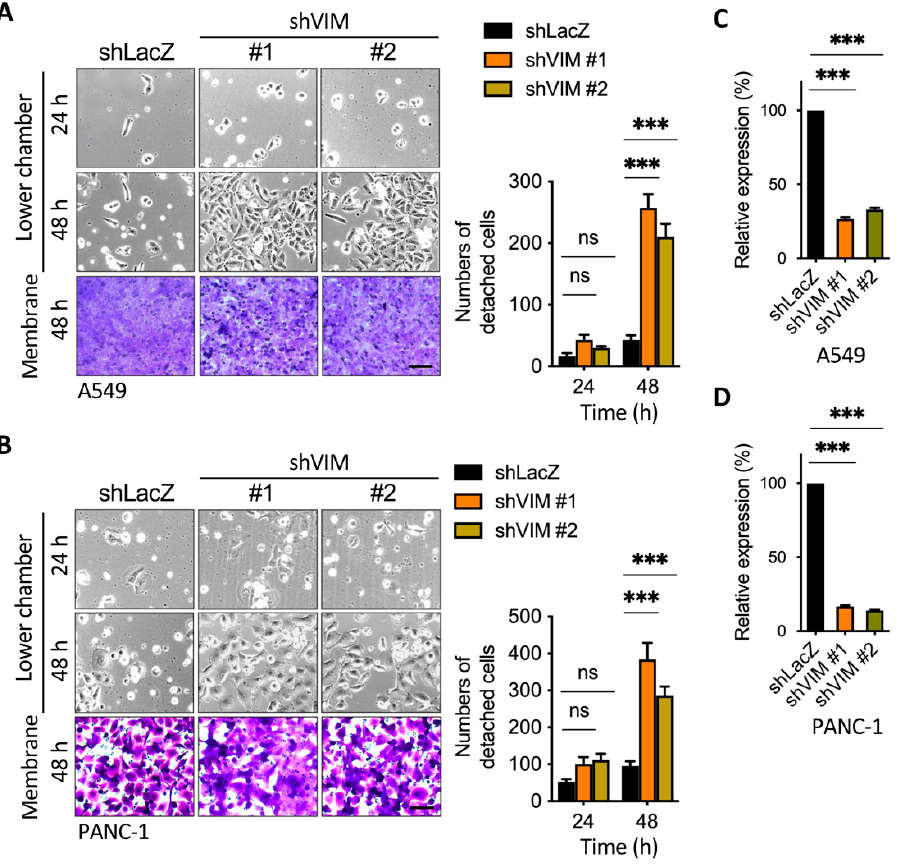
Figure 7. Silencing of vimentin induced cell detachment. ( A , B ) Images from the representative transwell assay; silencing of vimentin increased the leading cells detachment. A549 and PANC-1 cells were silenced with shLacZ or shVIM and seeded in the upper chamber overnight, and the transwell assay was performed for 24 and 48 h. The membranes were stained by crystal violet and the cell number from membranes or the lower chamber was counted. Scale bars: 100 μ m. *** p < 0.001. Data are means ± s.d. (two-way ANOVA with Tukey’s multiple comparisons test) from experiments with three replicates ( n = 3). ( C ) Relative expressions of vimentin mRNA in BFTC909-shLacZ, -shVIM#1, and shVIM#2 were determined by the real-time qPCR assay. ( D ) Relative expressions of vimentin mRNA in PANC-1-shLacZ, -shVIM#1, and shVIM#2 were determined by the real-time qPCR assay. *** p < 0.001. Data are means ± s.d. (one-way ANOVA with Dunnett’s multiple comparisons test) from experiments with three replicates ( n = 3). VIM, vimentin.